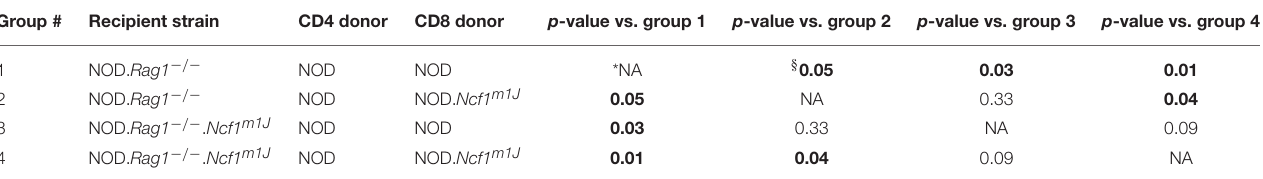
TABLE 1 | Significance matrix for the adoptive transfer studies. Group # Recipient strain CD4 donor CD8 donor p -value vs. group 2 p -value vs. group